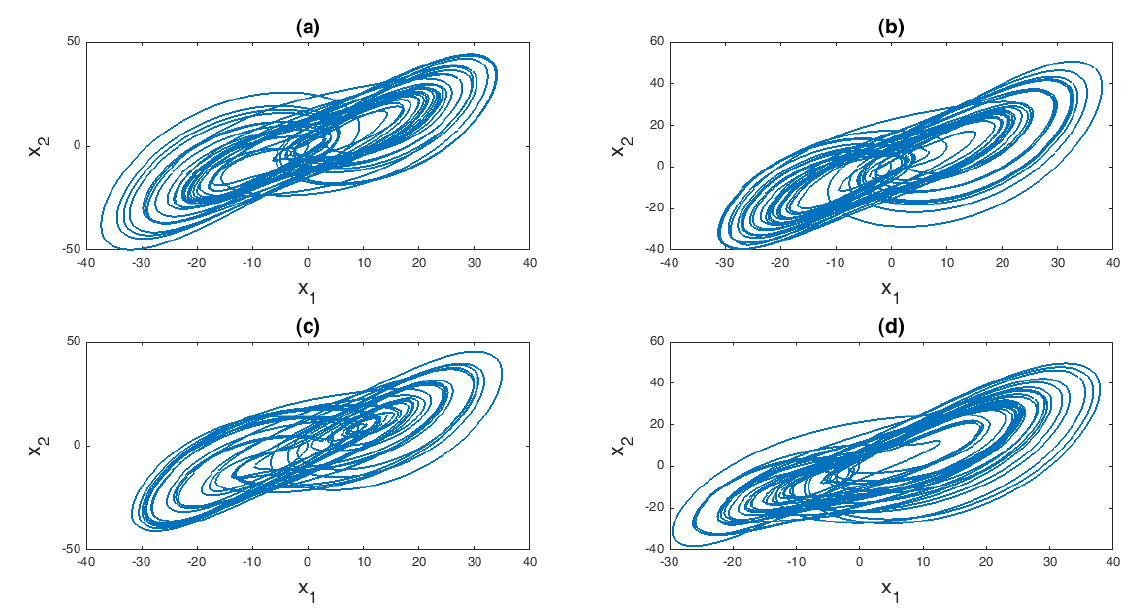
Figure 2. Phase portrait diagrams of the new hyper-chaotic system on the x 1 − x 2 space for different hyper–chaotic control parameters: ( a ) [ k = 0.002], ( b ) [ k = 0.2], ( c ) [ k = 0.85] and ( d ) [ k = 1].